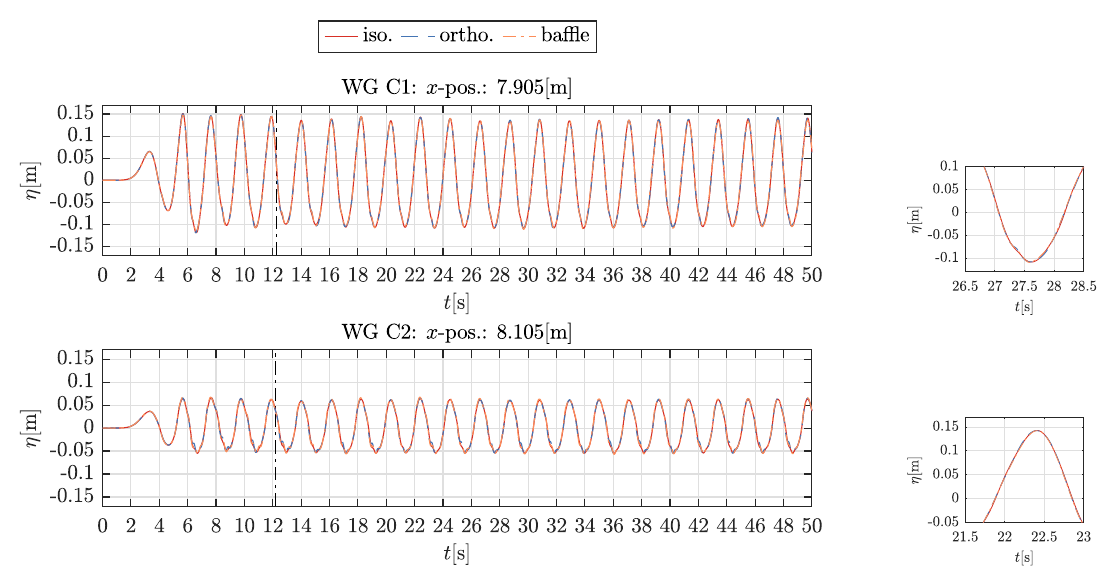
Figure 8. CFD results of the wave elevation, η ( t ) , at selected WGs close to the porous sheet for all types of porosity implementation, including the whole time series and selected